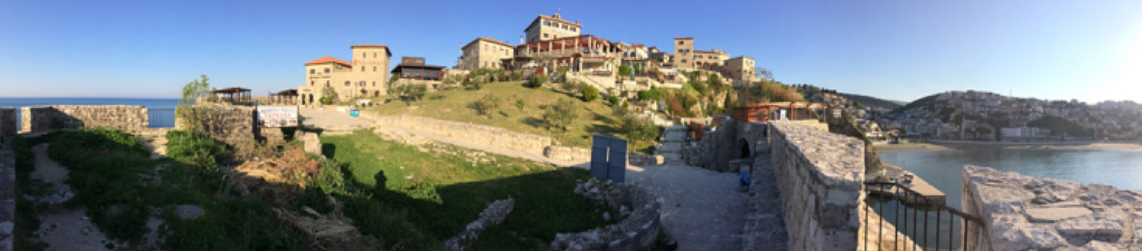
Fig. 4. Silhouette of the urban structure of Ulcinj, the city castle in the